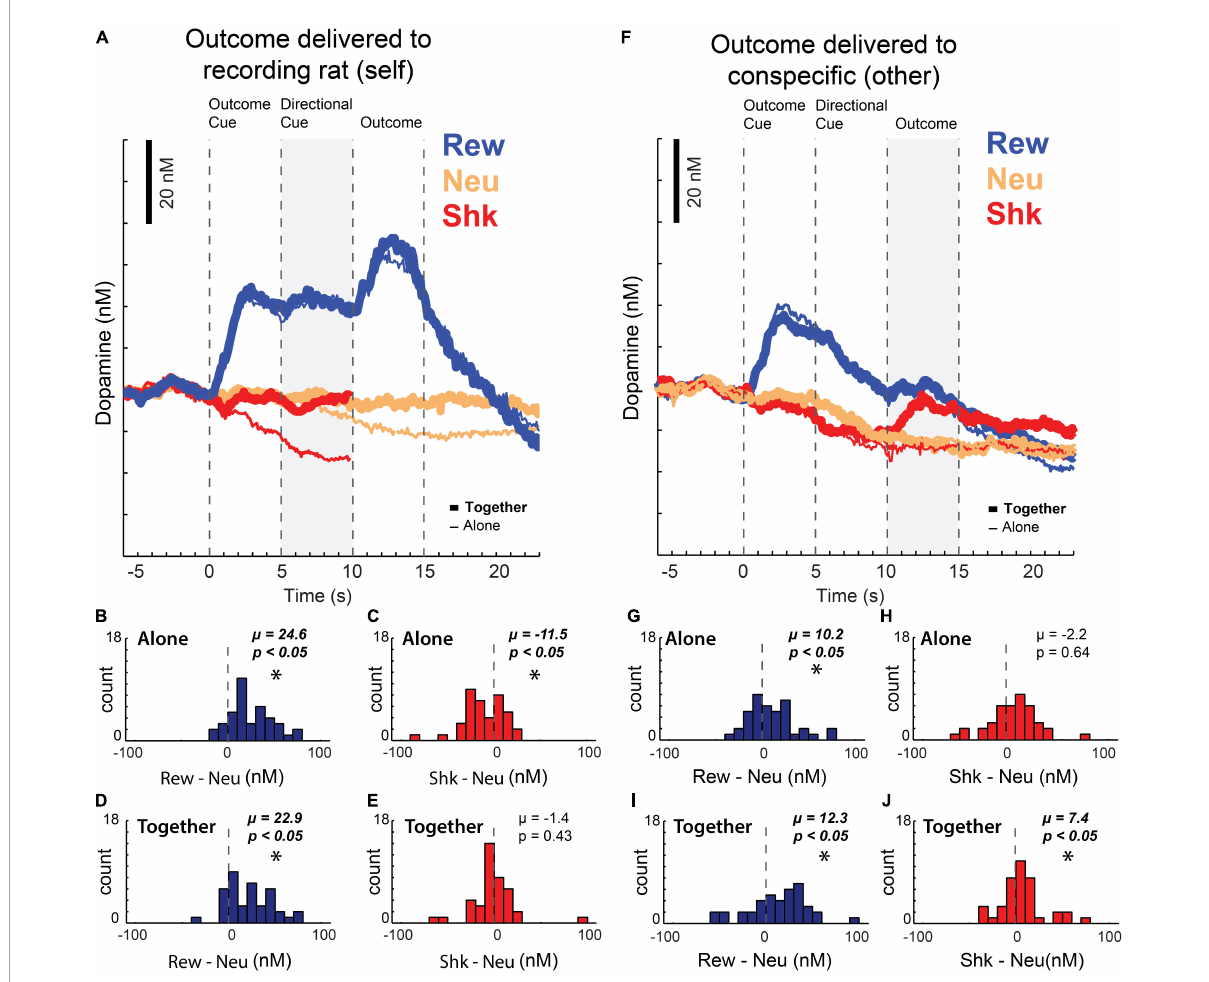
FIGURE4 (A) Average dopamine concentration over time on reward (blue), neutral (yellow), and shock (red) trials when the outcome was delivered to the recording rat – when the rat was with a conspecific (thick line) or alone (thin line) during performance of the task described in Figure 2 . Shock trials are truncated due to noise artifacts. (B–E) Reward (reward minus neutral) and shock (shock minus neutral) indices of dopamine release during the directional cue epoch (gray bar in A ) across sessions when the recording rat was alone (B,C) or with a conspecific (D,E) . (F) Same as (A) , but when the outcomes were being delivered to the conspecific (G–J) same as (B–E) , but when the outcomes were being delivered to the conspecific instead of to the recording rat (reward epoch = gray bar in F ). Asterisks denote significant shifts from zero; Wilcoxons, p < 0.05. Adapted from Lichtenberg et al.